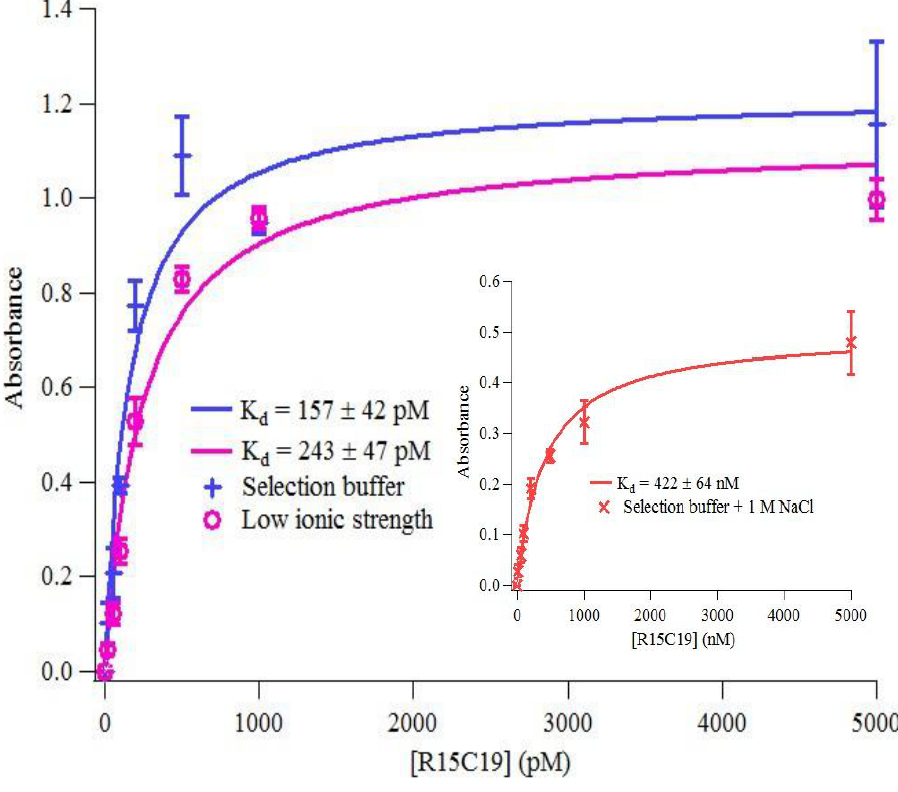
Figure 4. Binding of R15/19 to AChE under different conditions. The binding data were obtained from ELONA and were fitted into a hyperbolic equation (Langmuir model) using Igor Pro